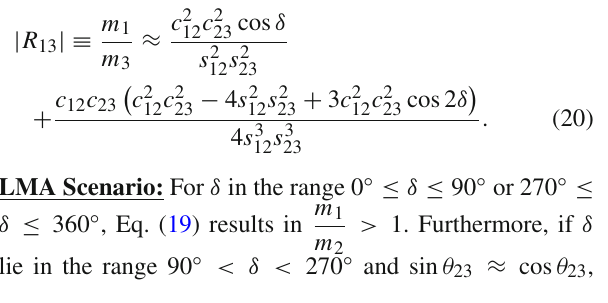
Table 6 Allowed/disallowed two-zero textures of M − 1 ν under LMA and LMA-D solutions. The (cid:2) ( × ) mark is used to denote allowed (disallowed) texture